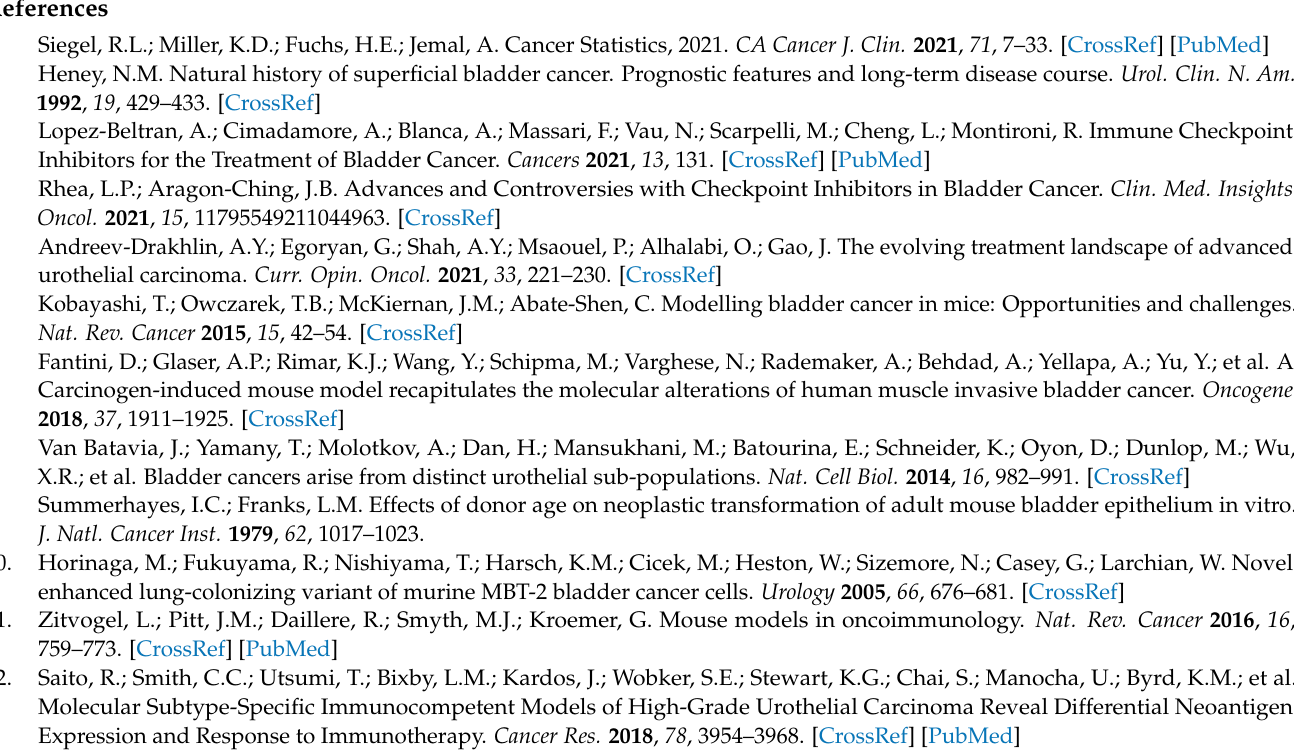
highly expressed tumor cells; Figure S7: the identification of immune cells in the TKO tumors; Figure S8: the gene set enrichment analysis of immune cells and tumor cells in responders and non-responders; Table S1: the primers used in this study for genotyping; Table S2: the antibodies used in this study; and Table S3: the cell counts and percentages of identified cell types in all cells. IPA data including the canonical pathway and upstream regulator analysis, and GSEA analysis data, are summarized in the Supplementary excel